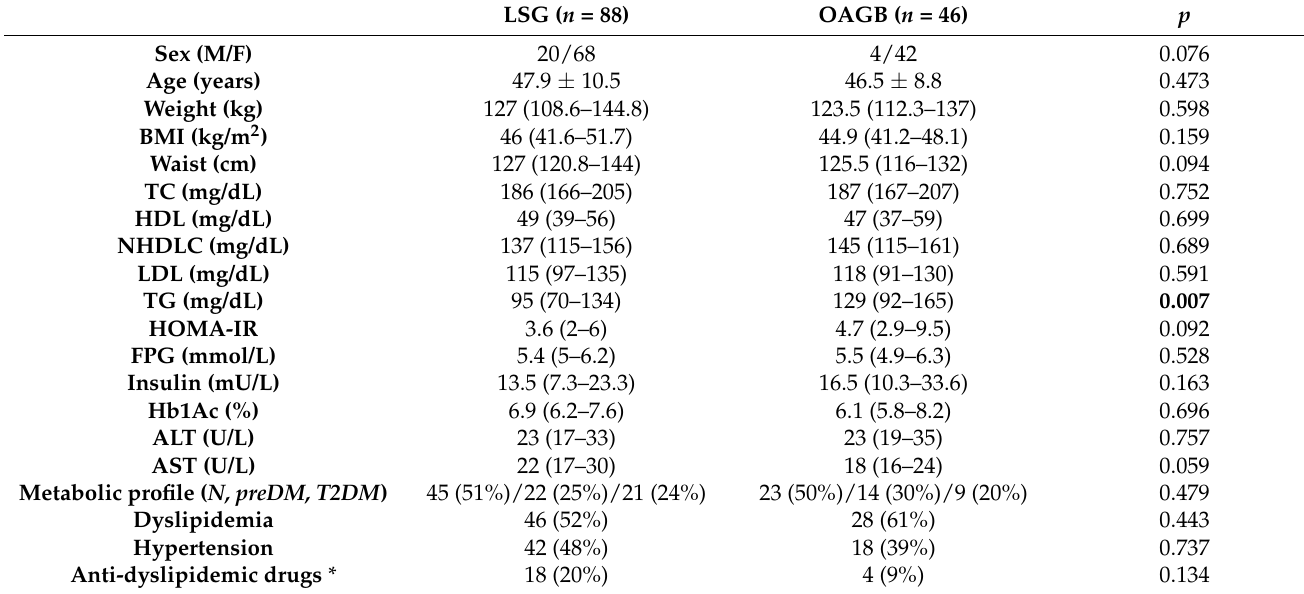
Table 1. Basal characteristics of patients underwent to laparoscopic sleeve gastrectomy (LSG) and one anastomosis gastric bypass